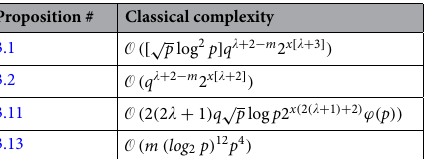
Table 1. Classical complexity of the best attacks we have discovered on the Optimized MPPK/DS scheme to this date.